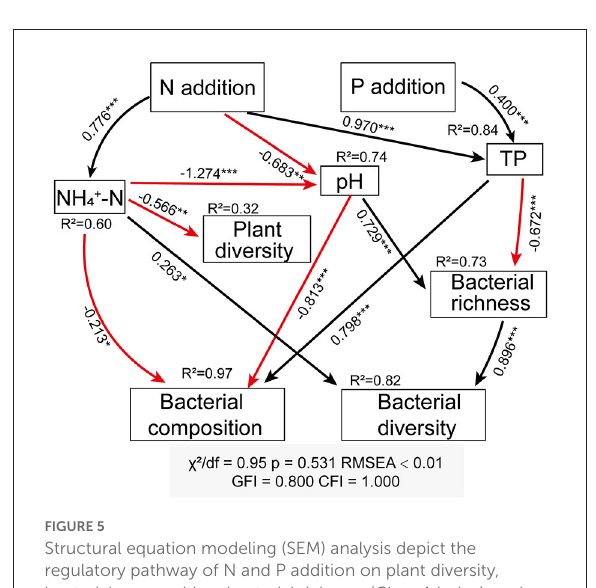
FIGURE5 Structural equation modeling (SEM) analysis depict the regulatory pathway of N and P addition on plant diversity, bacterial composition, bacterial richness (Chao 1 index), and bacterial diversity (Shannon index). The solid black arrow lines represent positive effects, solid red arrow lines represent negative effects. Adjacent numbers labeled in the same direction as the arrow represent standardized path coefficients. Values of R 2 indicate the proportion of variance explained by each variable in the model. *Indicates P < 0.05, **indicates P < 0.01, and ***indicates P <